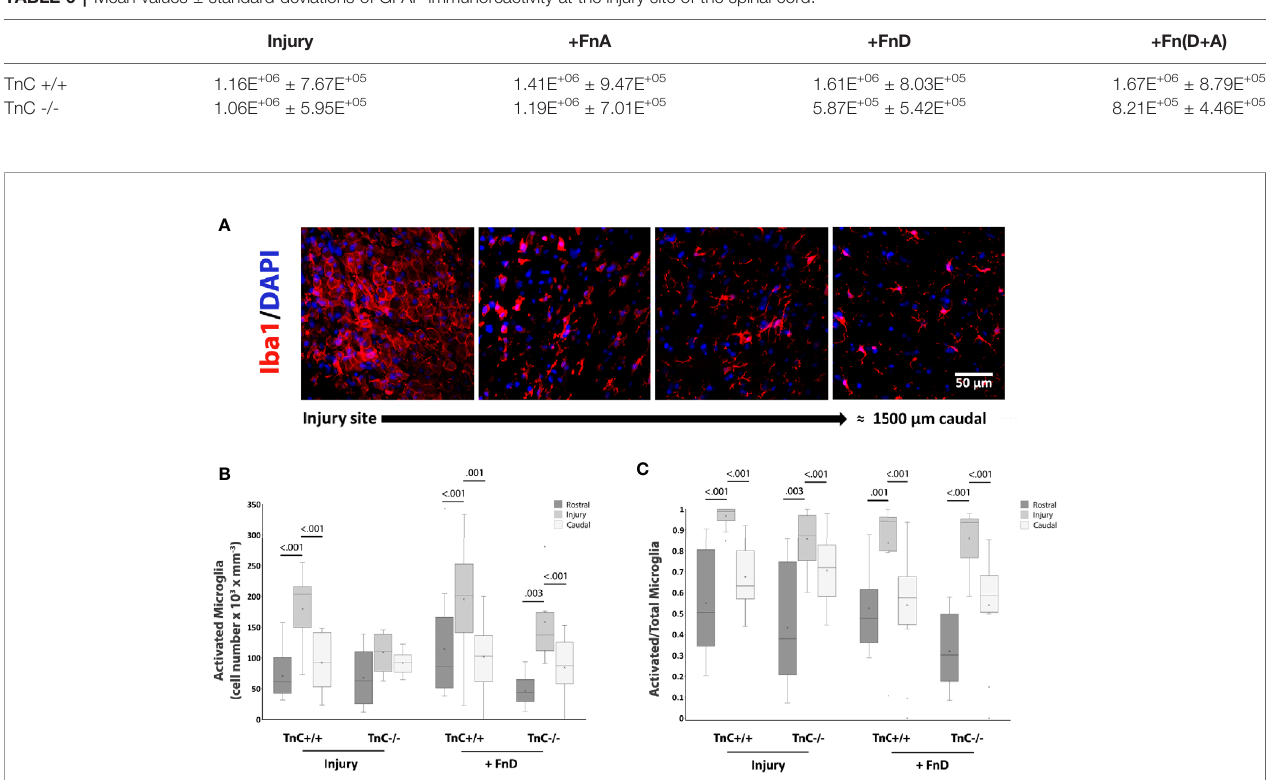
FIGURE 6 | TnC affects activation of microglia in the injury region. (A) Representative images of Iba1+ and DAPI immunostaining show activated, polygonal microglia framed by astrocytes, at the injury site, and a more quiescent microglia phenotype further away. Calibration bar for all panels: 50 m m. (B) Density of activated microglia by stereo-investigator analysis at the injury region and surrounding rostral and caudal regions of equal size 7 days after injury. Results are shown as a box- and-whisker plot. The effects of genotype and sampling position on the density of activated microglia are signi fi cant ( p < 0.001), as well as their interaction in the Injury group ( p = 0.032) as analyzed by three-way ANOVA. The density of activated microglia in TnC+/+ mice in the injury region is higher in TnC+/+ mice in both Injury and FnD groups compared to the other sampling positions ( p < 0.001). FnD application in TnC-/- mice increases the density of activated microglia at the injury region more so than rostrally ( p = 0.003) or caudally ( p < 0.001. (C) A box-and-whisker plot showing Activated/(Activated + Resting) microglia numbers per region. The proportion of activated microglia is higher at the injury site than rostrally and caudally in the injury and FnD groups of both genotypes ( p < 0.001). n = 3 animals per group for each